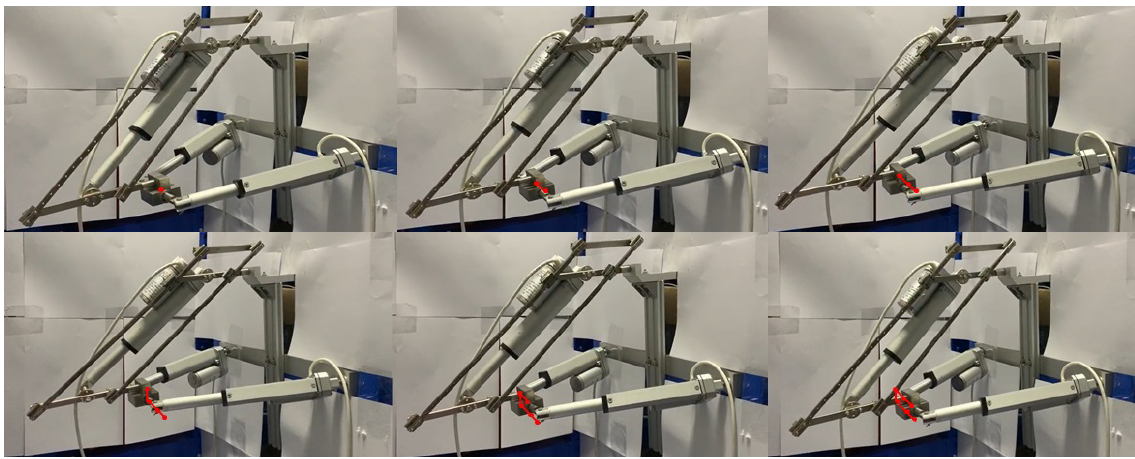
Figure 23. “ ⊂ ” shaped